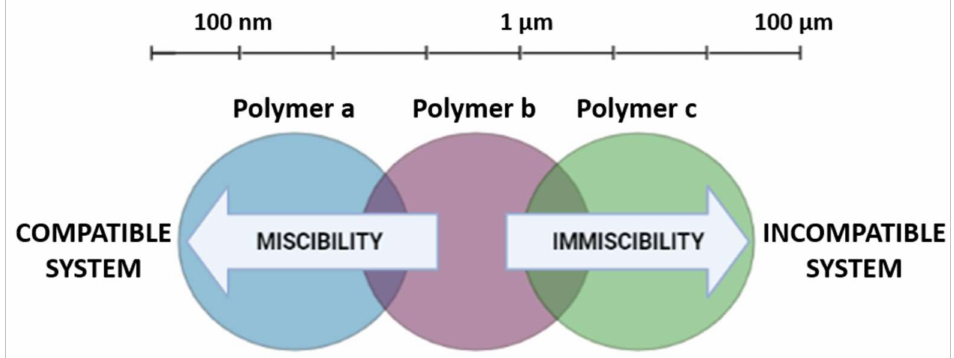
Figure 1. Miscibility vs. compatibility of polymer